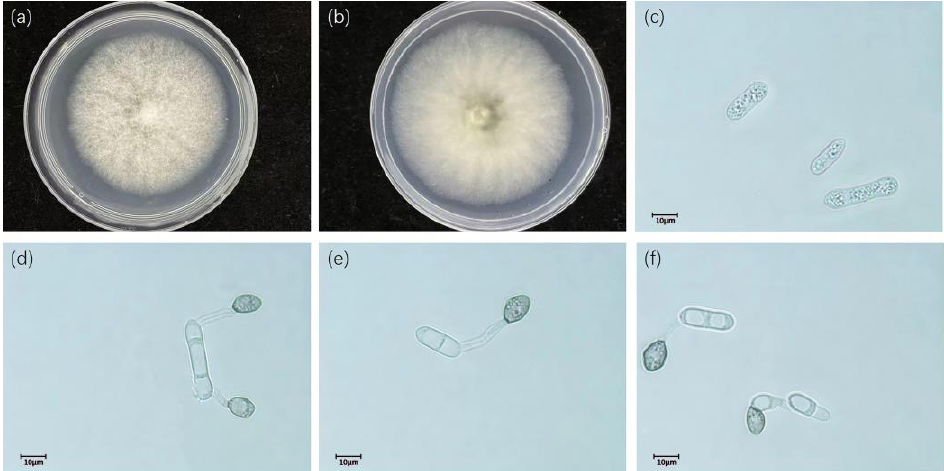
Figure 4. Colletotrichum fructicola (HNHH7-1). ( a ) Colony on PDA. ( b ) Reverse side of the colony on PDA. ( c ) Conidia. ( d – f ) Appressoria. Scale bars = 10 µm.